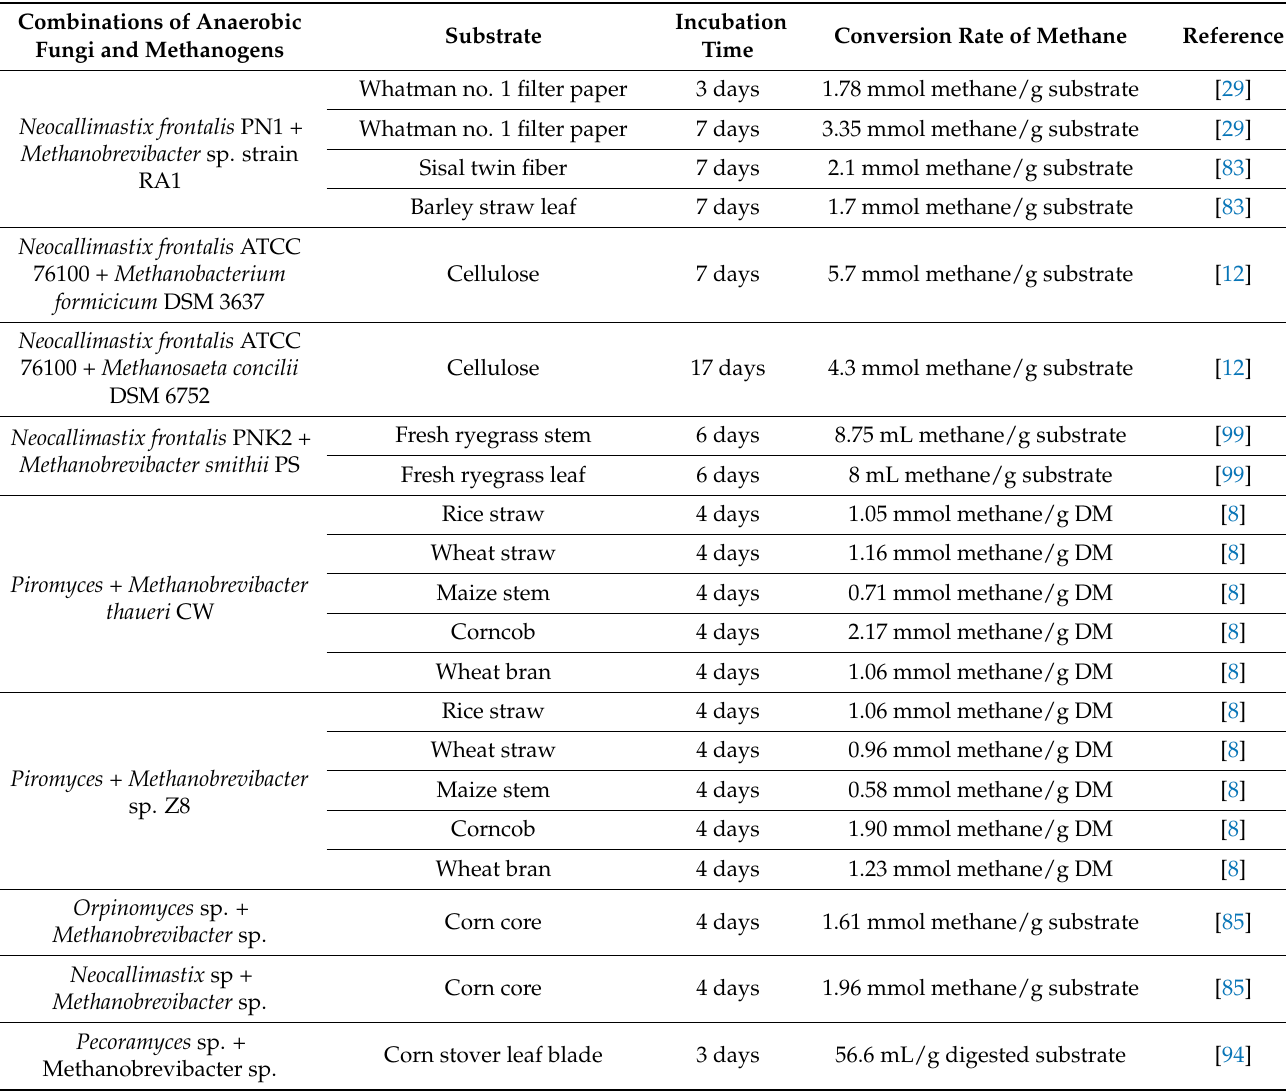
Table 3. Summary of methanogenesis in co-cultured anaerobic fungi and methanogens with different lignocellulosic materials. Combinations of Anaerobic Fungi and